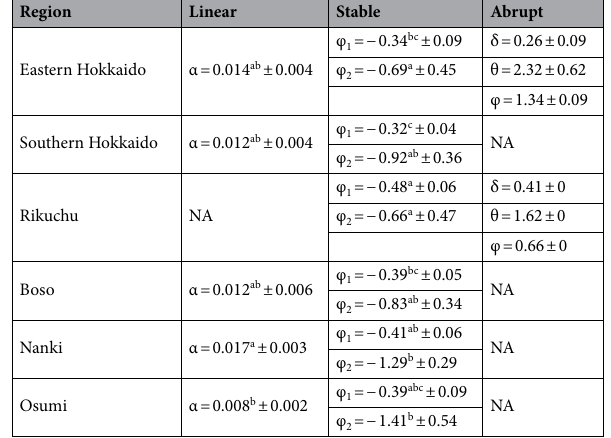
Table 2. Summary of model coefficients (mean ± SD) for each trajectory found for communities of rocky intertidal sessile organisms in six regions along the Pacific coast of Japan. Different superscript letters signify statistically significant differences as shown by post hoc Bonferroni pairwise comparisons ( P < 0.05). NA (not available) indicates that a trajectory was not applicable in a particular region.